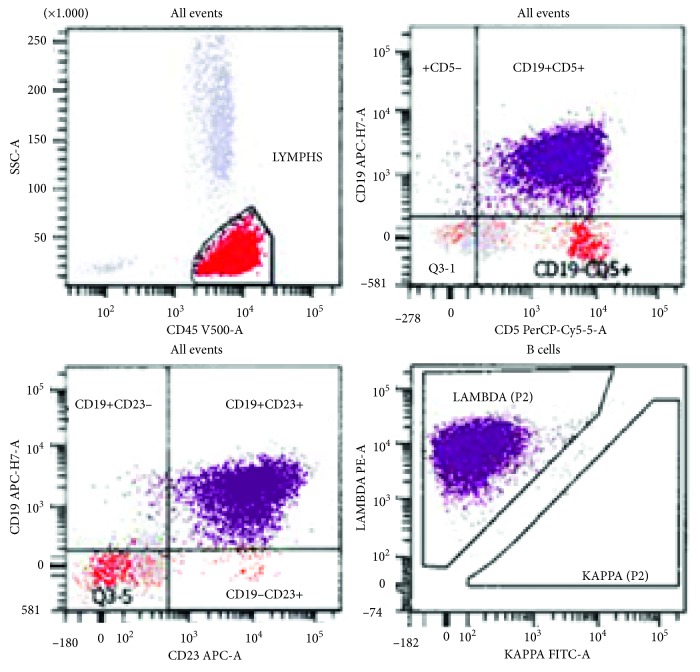
CSF flow cytometry.